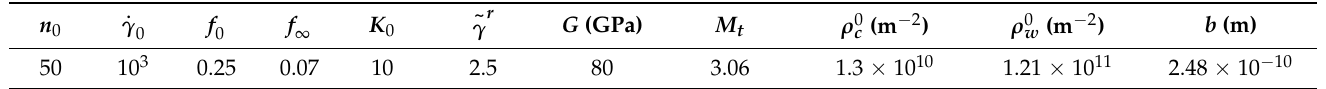
Table 5. Dislocation-density-model parameters for AerMet100 steel